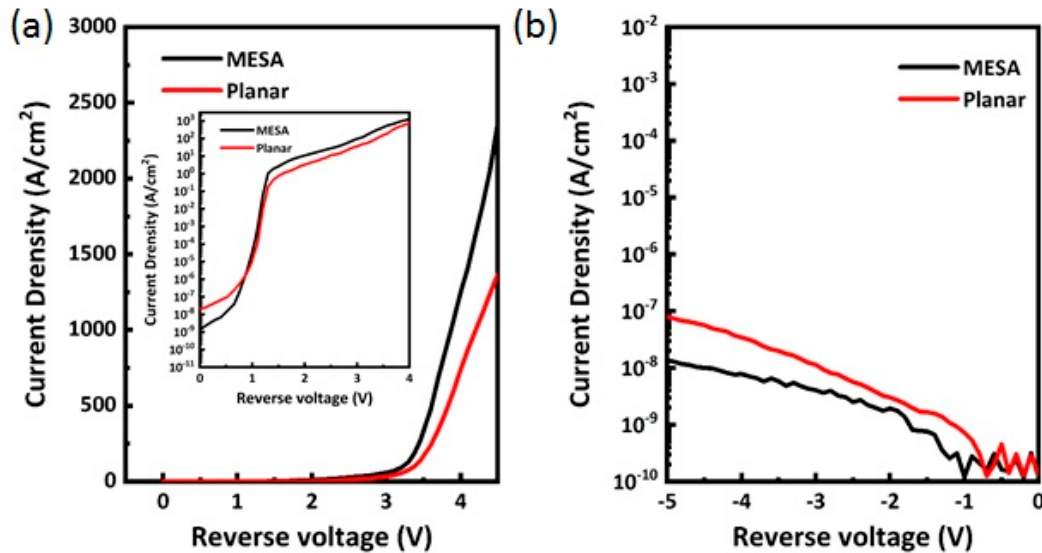
Figure 4. ( a ) Forward current and ( b ) reverse current as a function of bias. Forward current and specific on-resistance are normalized by the pad size. The inset of Figure 4a shows the forward I-V curves in a semilog scale.